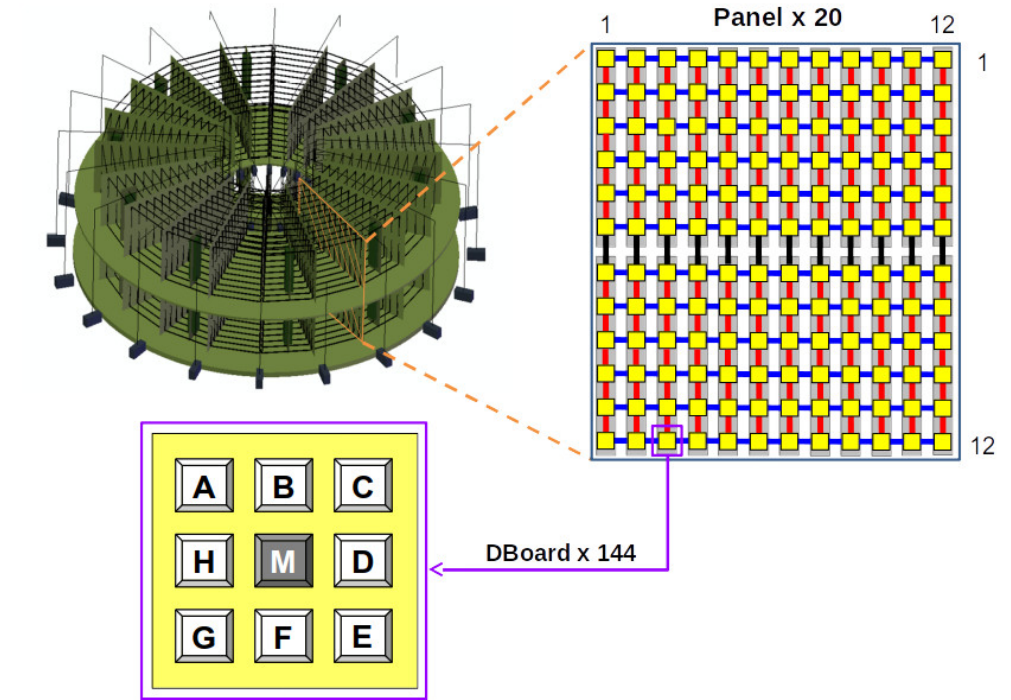
Figure 1. General architecture of